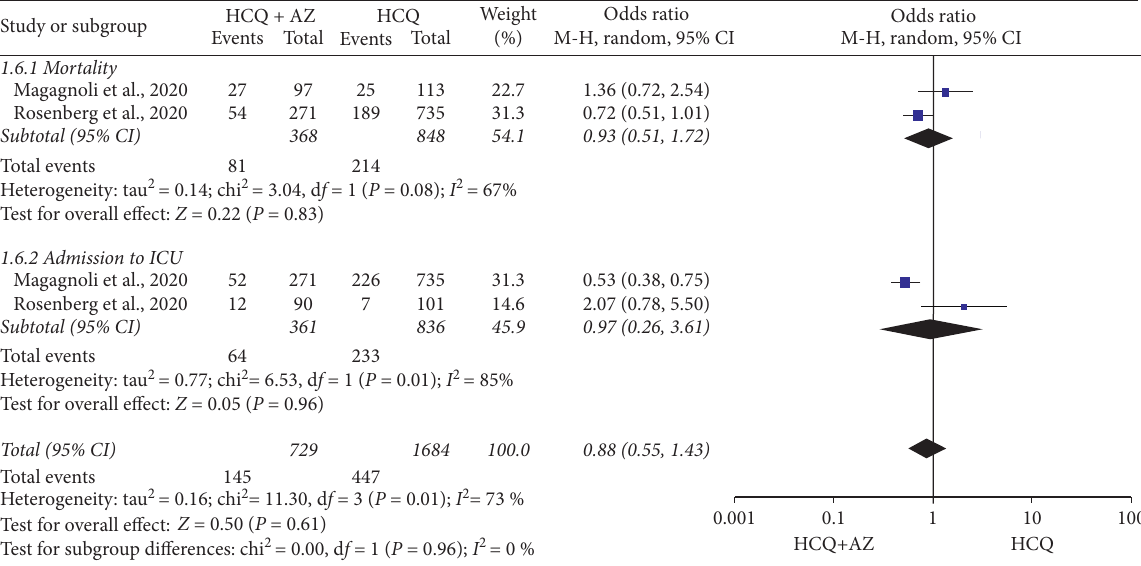
Figure 11: Risk of death or ICU admission in patients exposed to HCQ versus HCQ +AZ.